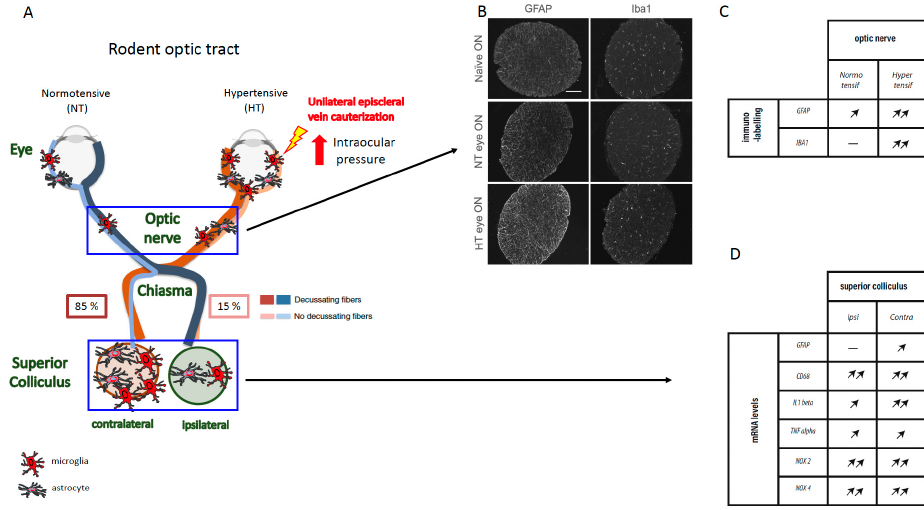
Figure 1. Elevated intraocular pressure (IOP) over 40 days after episcleral vein cauterization (EVC) in rat induced astrogliosis and microgliosis in the optic nerve and superior colliculus. ( A ) Diagram showing the rodent neuronal visual pathway. Immunofluorescent labeling of glial fibrillary acidic protein (GFAP) and ionized calcium binding adaptor molecule 1 (Iba1) in ( B ) naïve, contralateral (normotensive, NT), and hypertensive (HT) optic nerves. Scale bar, 100 µ m. ( C ) Table of the variations of GFAP and Iba1 immunofluorescence levels in the NT and HT optic nerves, 40 days after EVC. ( D ) Table of the variations in the mRNA expression levels of inflammatory markers (i.e., GFAP, CD68, IL1 β , TNF α , Nox2, and Nox 4) in ipsilateral and contralateral superior colliculus (SC), 40 days after EVC (Adapted from Sapienza et al.).